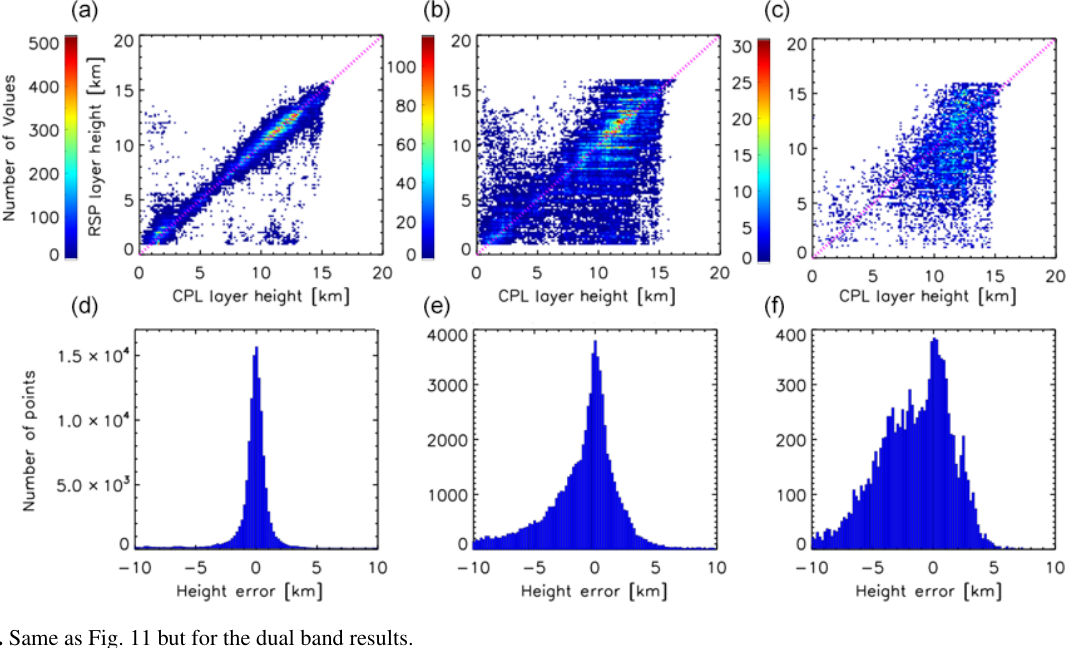
Figure 13. Same as Fig. 11 but for the dual band results.